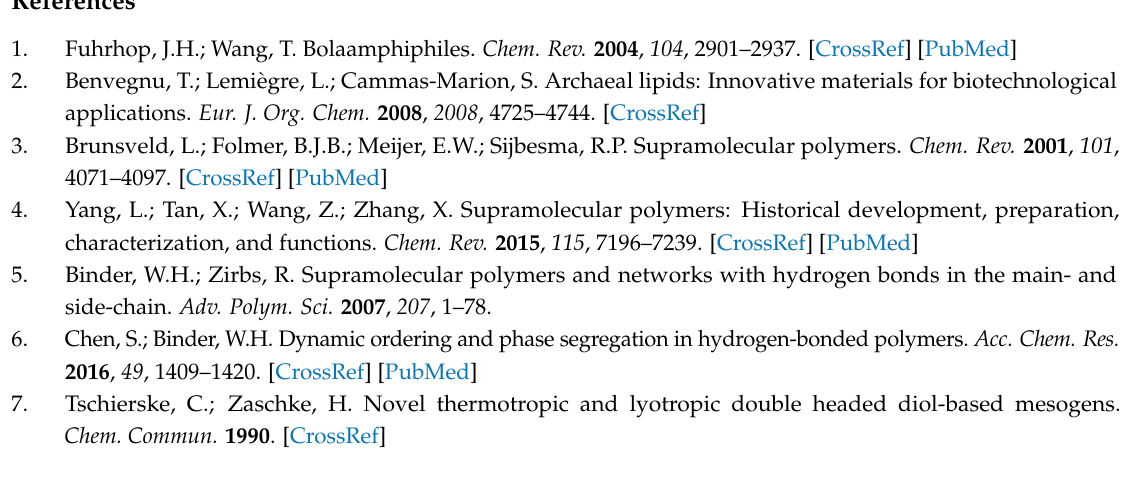
Tables S4–S6: Structural data. Synthesis and analytical data of all new compounds with Schemes S1–S5 showing details of the synthesis and Figures S9–S30 showing representative NMR spectra of selected